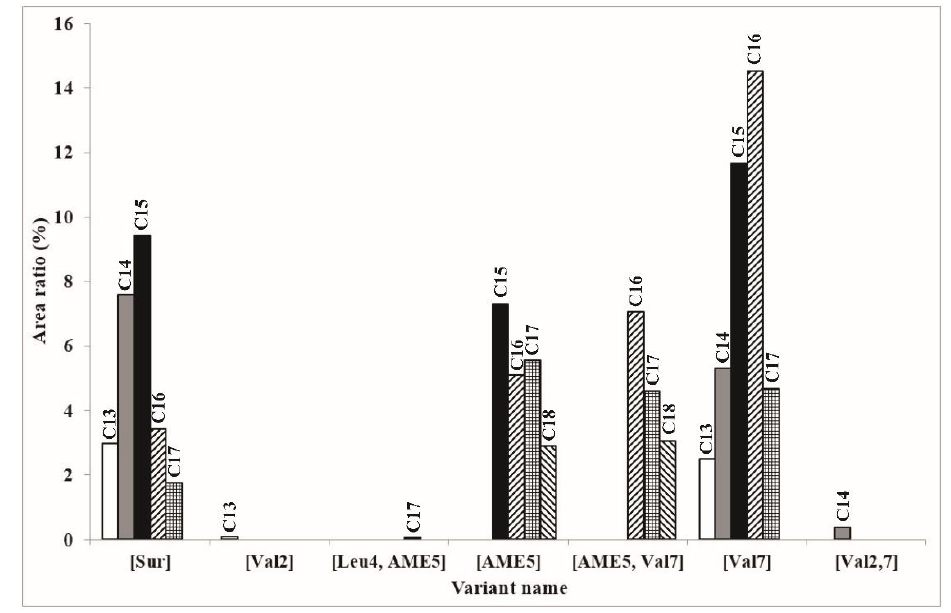
Figure 7. The summarizing diagram of all the different surfactin molecules and their homologues found in B. subtilis SZMC 6179J.